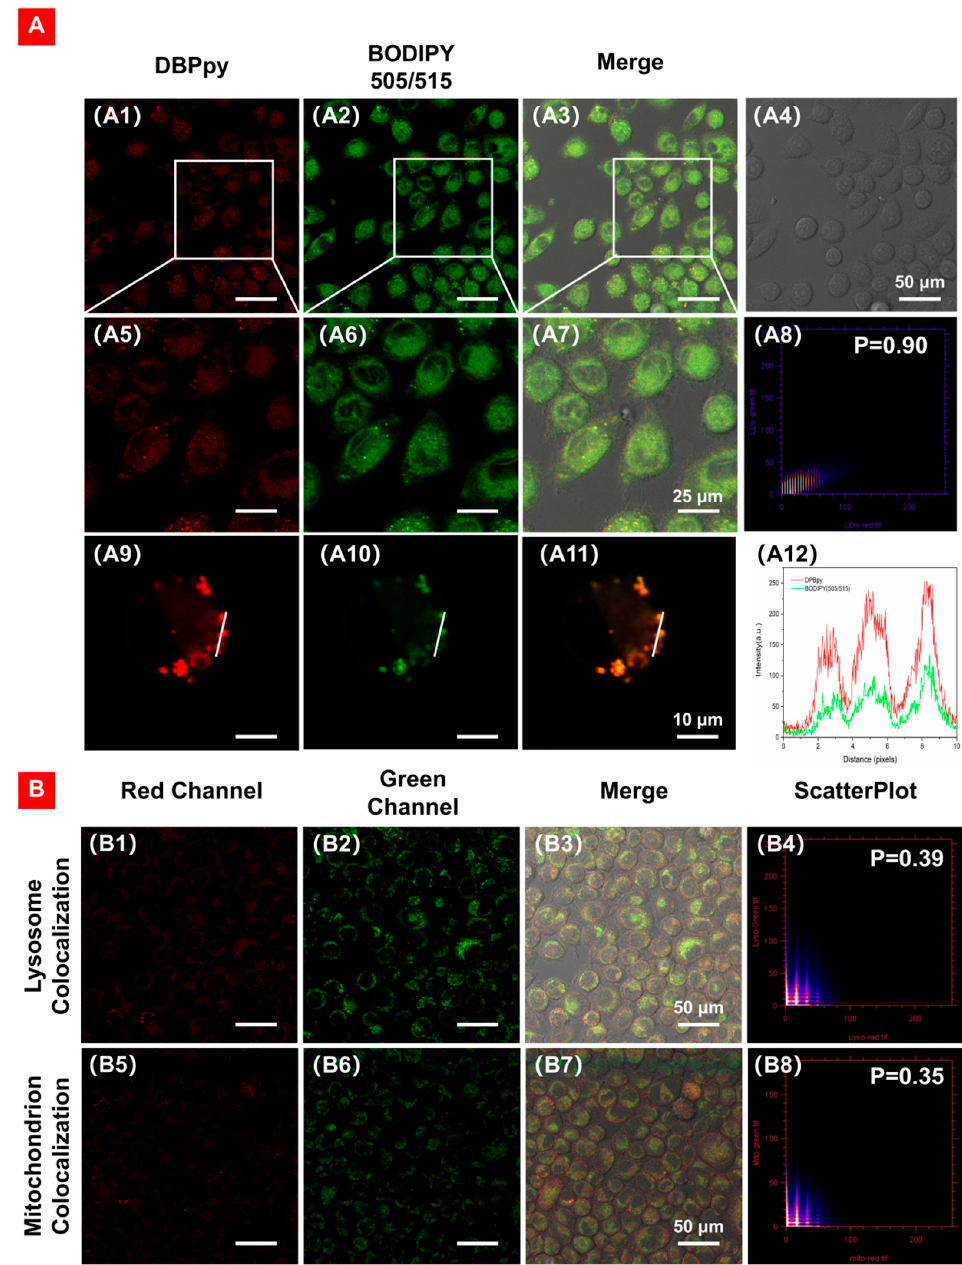
Figure 6. ( A ) CLSM of HeLa cells co-stained with ( A1 , A5 , A9 ) DBPpy (10 μ M, red channel), ( A2 , A6 , A10 ) BODIPY 505/515 (5 μ g·mL − 1 , green channel), ( A3 , A7 , A11 ) overlay images of red chan- nel, green channel and bright field, ( A4 ) bright field, ( A8 ) intensity correlation plot of BODIPY 505/515 and DBPpy, R = 0.90, and ( A12 ) intensity profiles of ROI across a HeLa cell. λ ex : 550 nm; λ em : 650–750 nm for DBPpy (red); λ ex : 490 nm; λ em : 500–530 nm for commercial fluorophores (green). ( B ) Co–localization of DBPpy with lysosomes ( B1 – B4 ) and mitochondria ( B5 – B8 ).